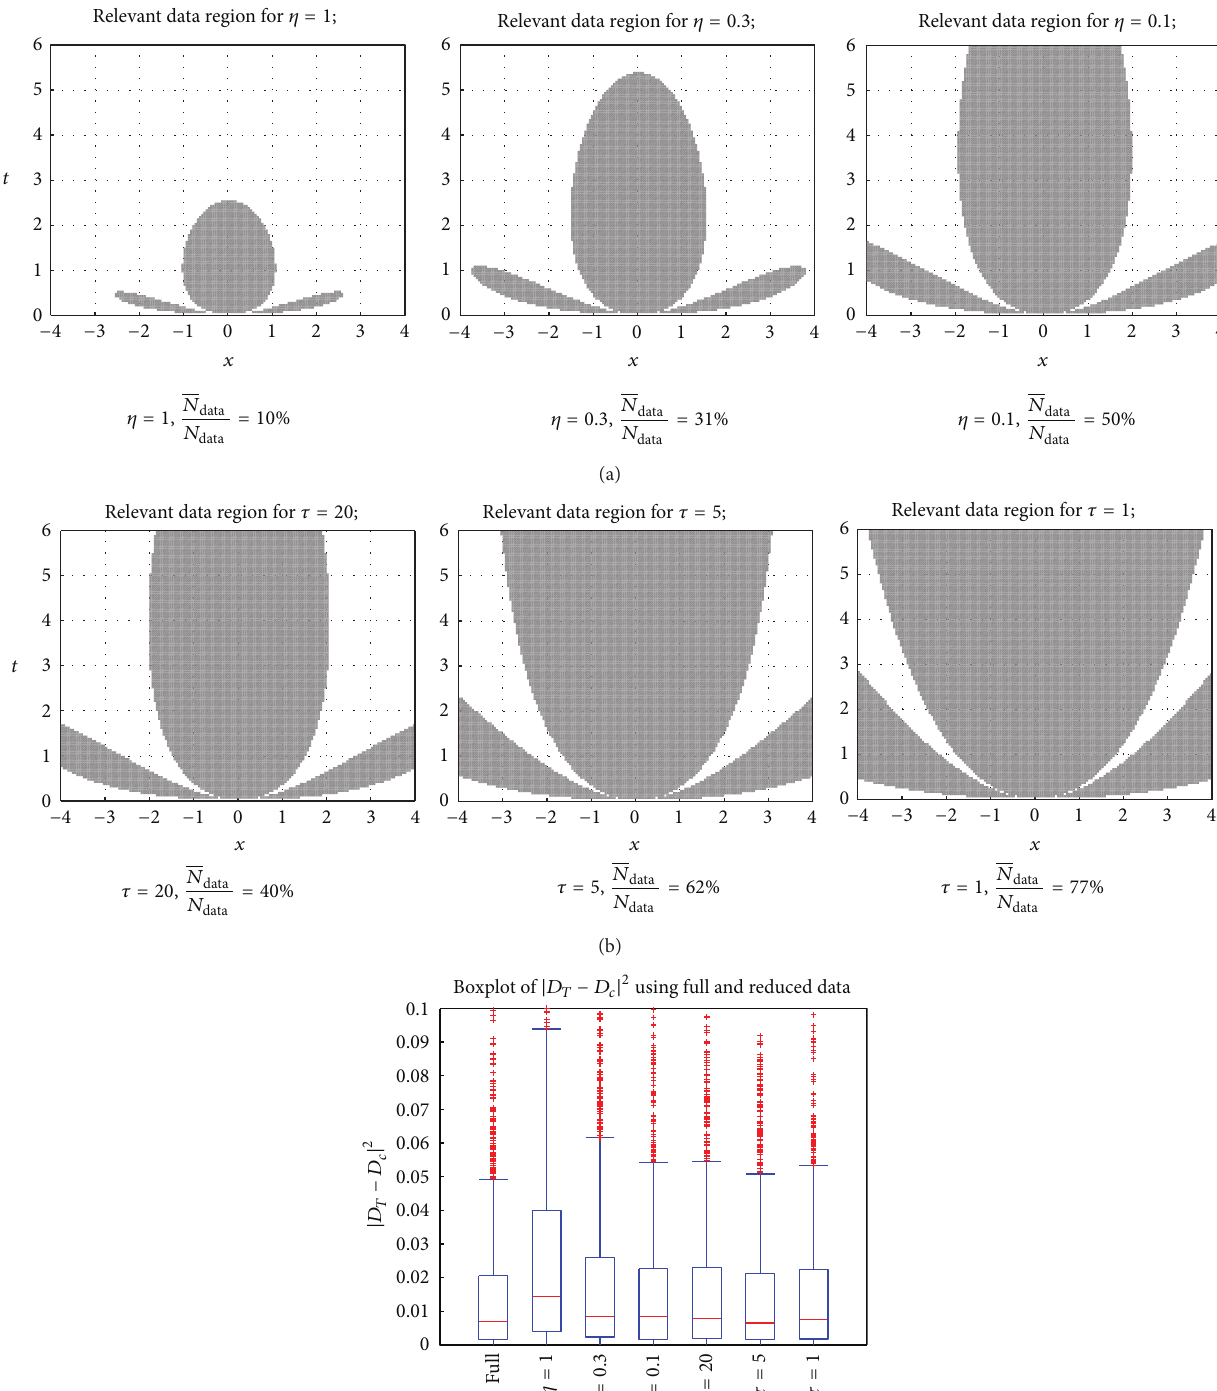
Figure 2: Examples of data reduction. Gray color indicates the data space, where the relevant data are taken. White color represents the data regions of irrelevant data points. (a) Relevant data region using (27) with 𝜂 = 1 , 0 . 3 , 0 . 1. (b) Relevant data region using (30) with 𝜏 = 20 , 5 , 1. (c) Boxplot of the distribution of the squared error |𝐷 𝑇 − 𝐷 𝑐 | 2 based on 1000 noisy signal samples using full and reduced data; cross marks (+) indicates the outliers. The data were simulated using (8), with an exact diffusion coefficient 𝐷 𝑇 = 2, bleach radius 𝑟 white Gaussian noise with standard deviation 𝜎 = 0 .